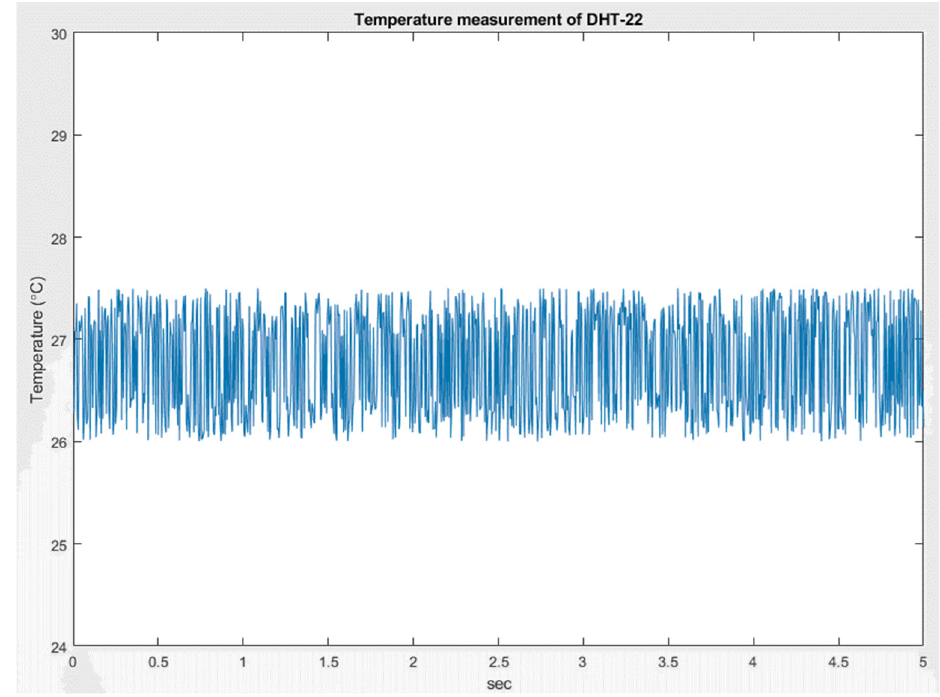
Figure 14. Temperature measured by DHT-22.